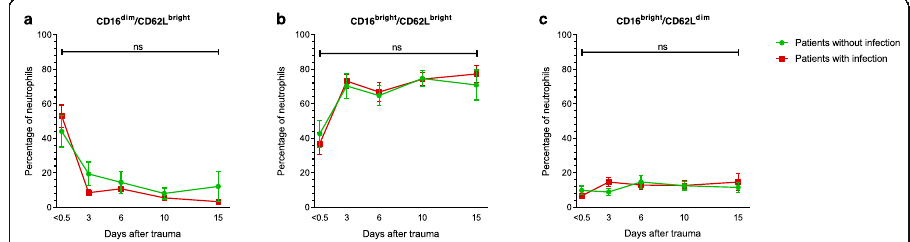
Fig. 1 Neutrophil subsets. Percentage of CD16 dim /CD62L bright cells ( a ), CD16 bright /CD62L bright cells ( b ), and CD16 bright /CD62L dim cells ( c ) of patients who developed an infection (red square) and patients who did not (green circle). Patients who developed an infection were compared to patients without infection using generalized estimating equations. No statistically significant differences were found between these groups. Additionally, groups were compared per time point using Student ’ s T test with correction for multiple comparisons with the Hom-Sidak method. Again, no statistically significant differences were found between groups. Data are presented as mean with the standard error of the